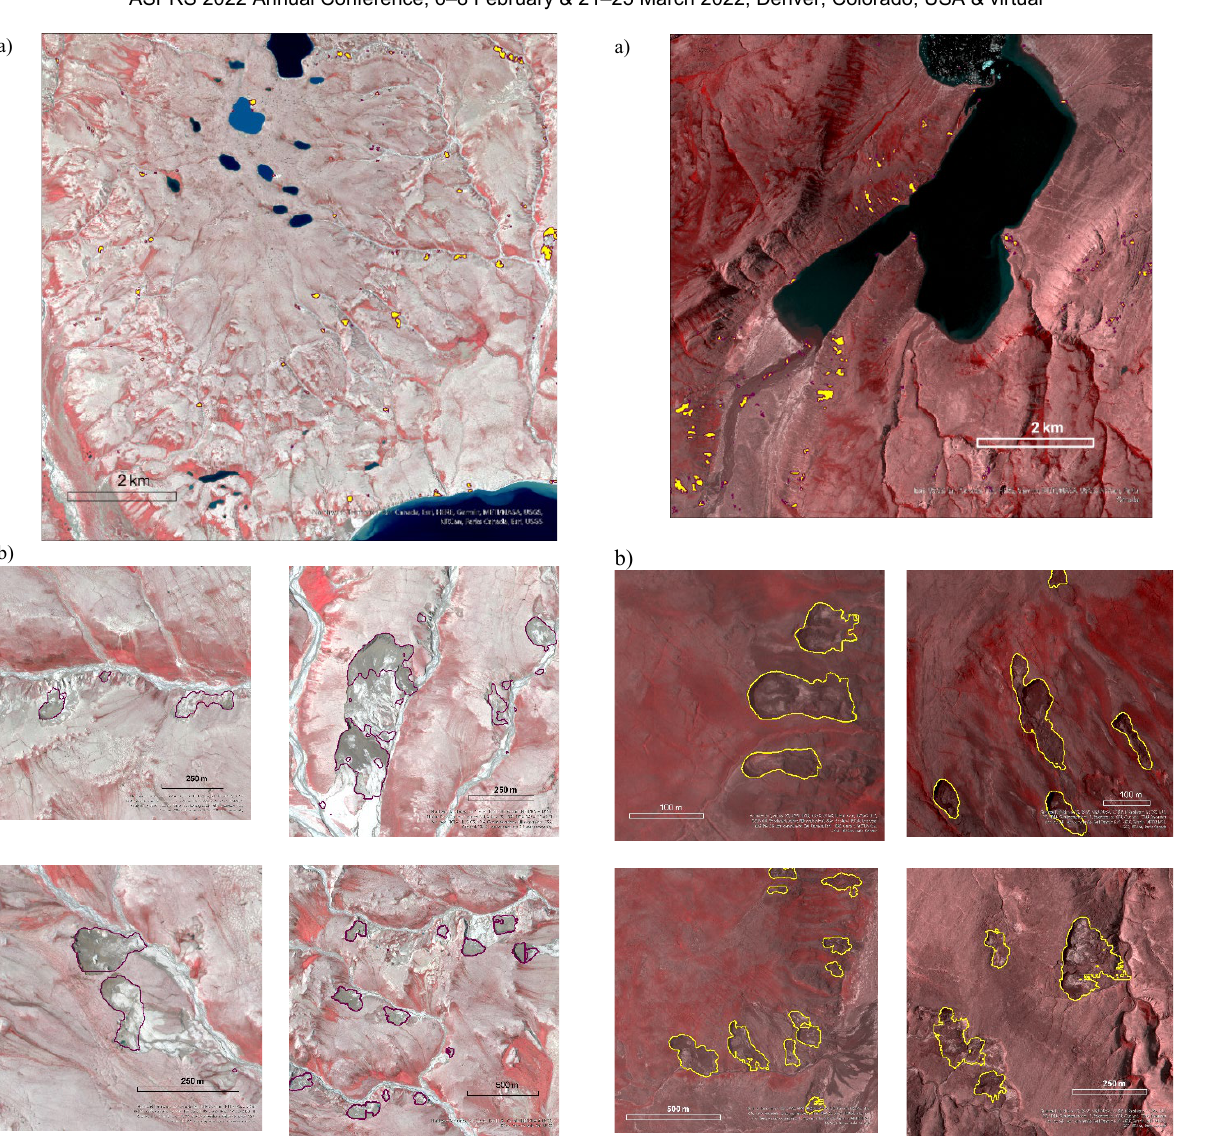
Figure 16 demonstrates the potential of multi-temporal RTS detection. Figure 16(a) and (b) correspond to images acquired in 2015 and 2019, respectively. The green outline represents prediction based on the 2015 image and the yellow outline represents the RTS detection based on the 2019 image. As shown in the figures, we can clearly see the upward movement of the headwall in 2019. The 2015 scar zone had been stabilized by 2019. This example elucidates the potential usage of the DLCNN approaches for monitoring RTS activity using high-resolution satellite imagery. Because of the sub-meter scale spatial resolution, it is possible to differentiate RTS’ morphometric variations.